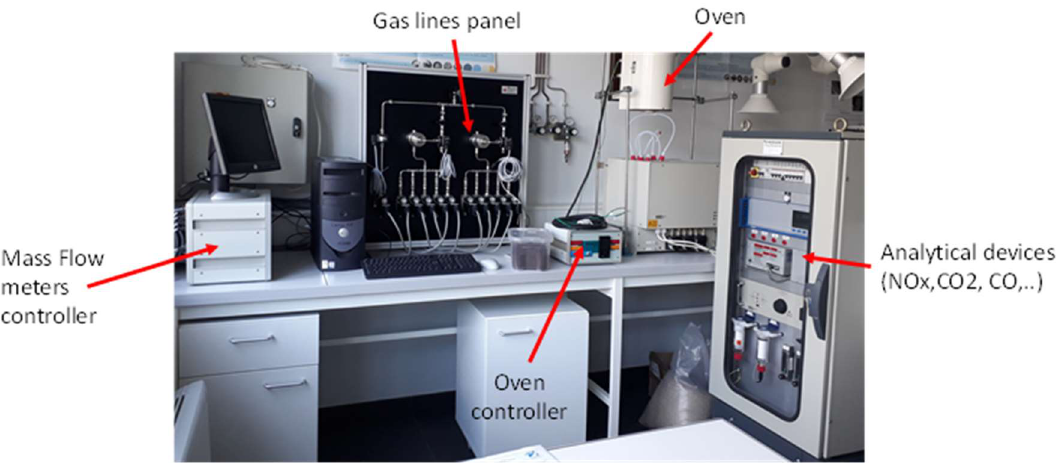
Figure 1. Photo of the Experimental bench used for the NO 2 adsorption tests.